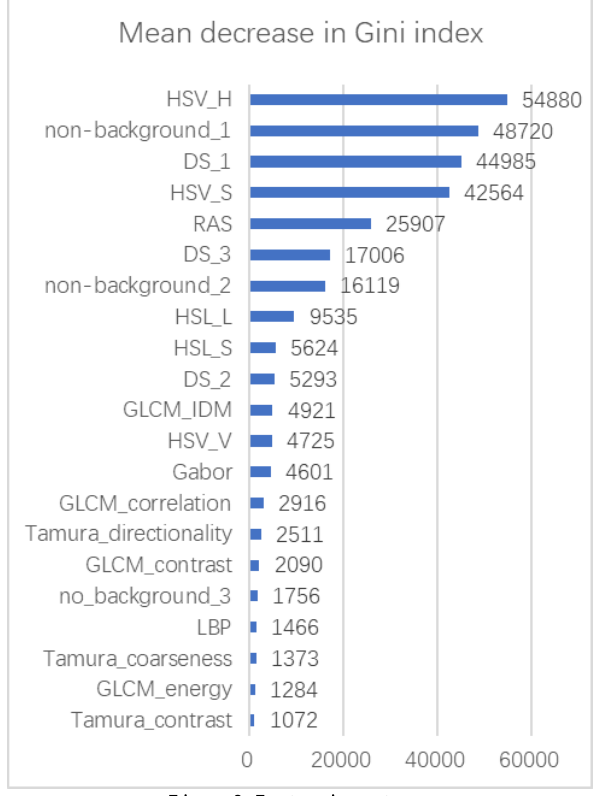
Figure 8. Feature importance